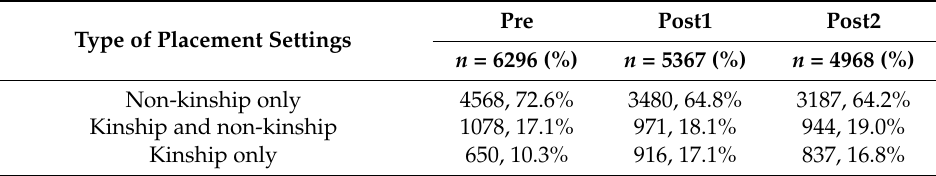
Table 4. Type of placement settings among children placed continuously.